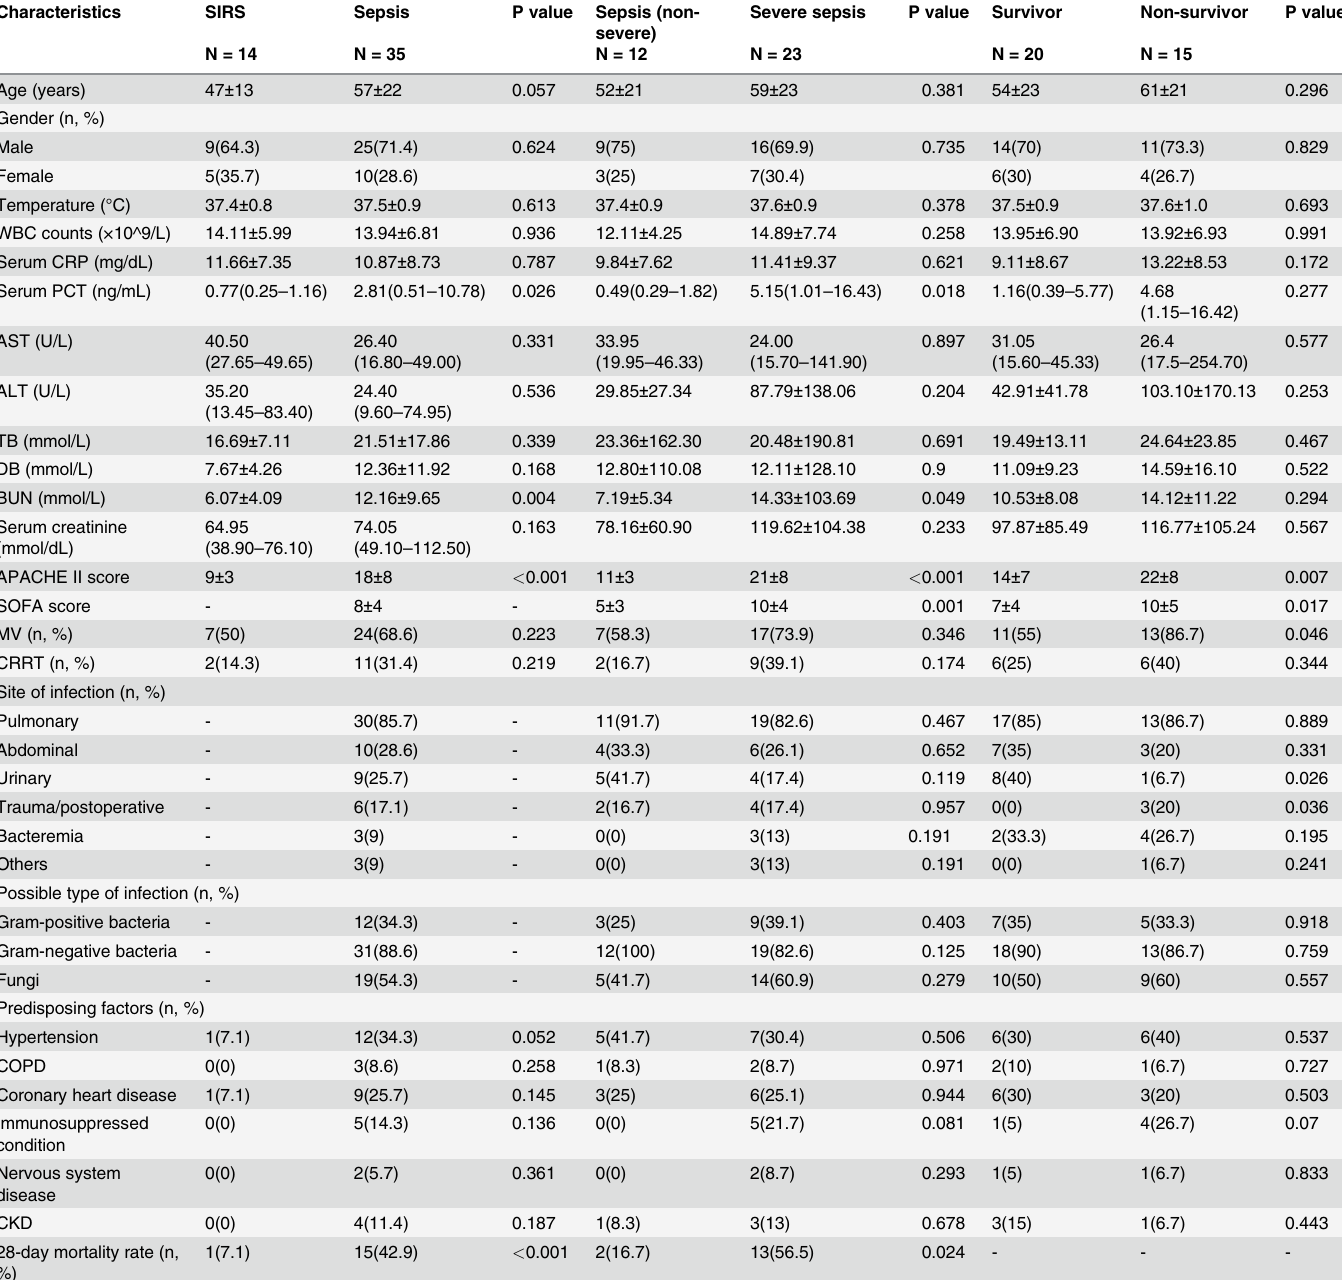
Table 1. The clinical characteristics at ICU admission of patients involved in this study.